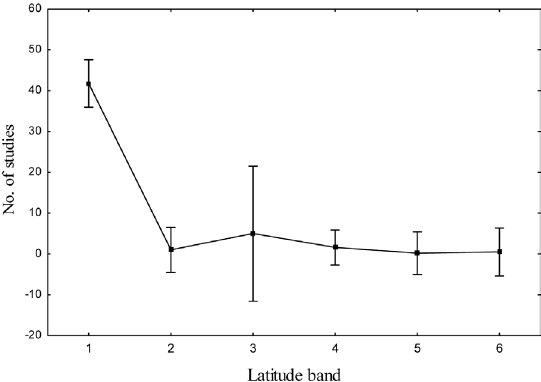
Figure 5. Distribution of the number of studies by latitudinal band. Symbols for the latitudinal bands: band 1: from 71°N to 43°N, band 2: from 42°59´N to 20°N, band 3: from 19°59´N to 0°, and band 4: from 0° to 20°S. When more than one band is involved (i.e. 1–2, 2–3, etc.), this means that the given genus occurs in both latitudinal